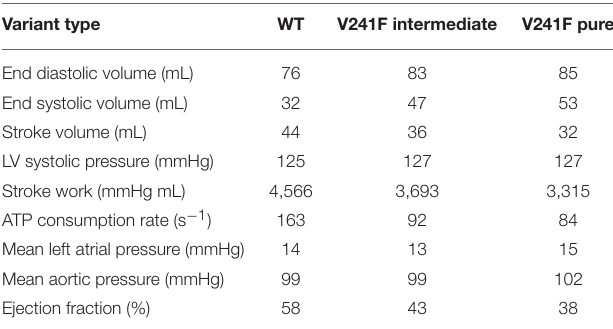
TABLE 1 | Ventricular mechanical responses during sinus rhythm under WT, V241F intermediate, and V241F pure mutation conditions. Variant type